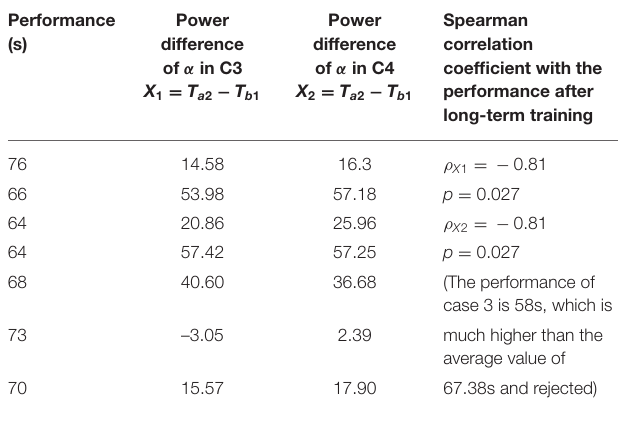
TABLE 1 | Electroencephalogram (EEG) power spectrum of α band before and after the stimulation.